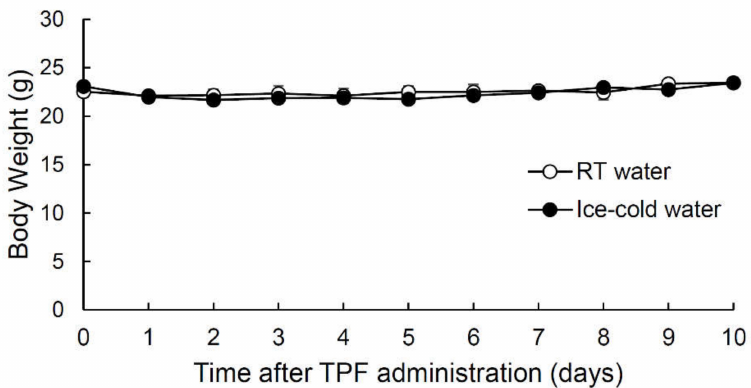
Figure 1. Temporal changes in the body weight of mice that drank either room temperature (RT) water or ice-cold water during the 10-day period following the intraperitoneal administration of TPF (docetaxel, cisplatin and 5-fluorouracil). Data are expressed as the mean ± SEM ( n = 4 mice, each). 2.2. Taste Cell Apoptosis after TPF Administration Was Suppressed by the Drinking of Ice-Cold Water Each of the anticancer drugs in TPF induces apoptotic cell death [16–18]. Therefore, we used the terminal deoxynucleotidyl transferase-mediated dUTP nick end labeling (TUNEL) assay to